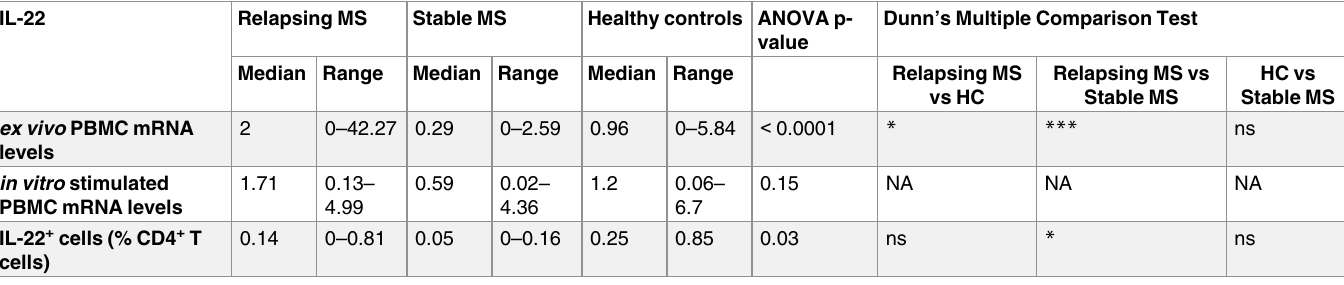
Table 3. IL-22 expressionanalysis in PBMCs of MS patients and